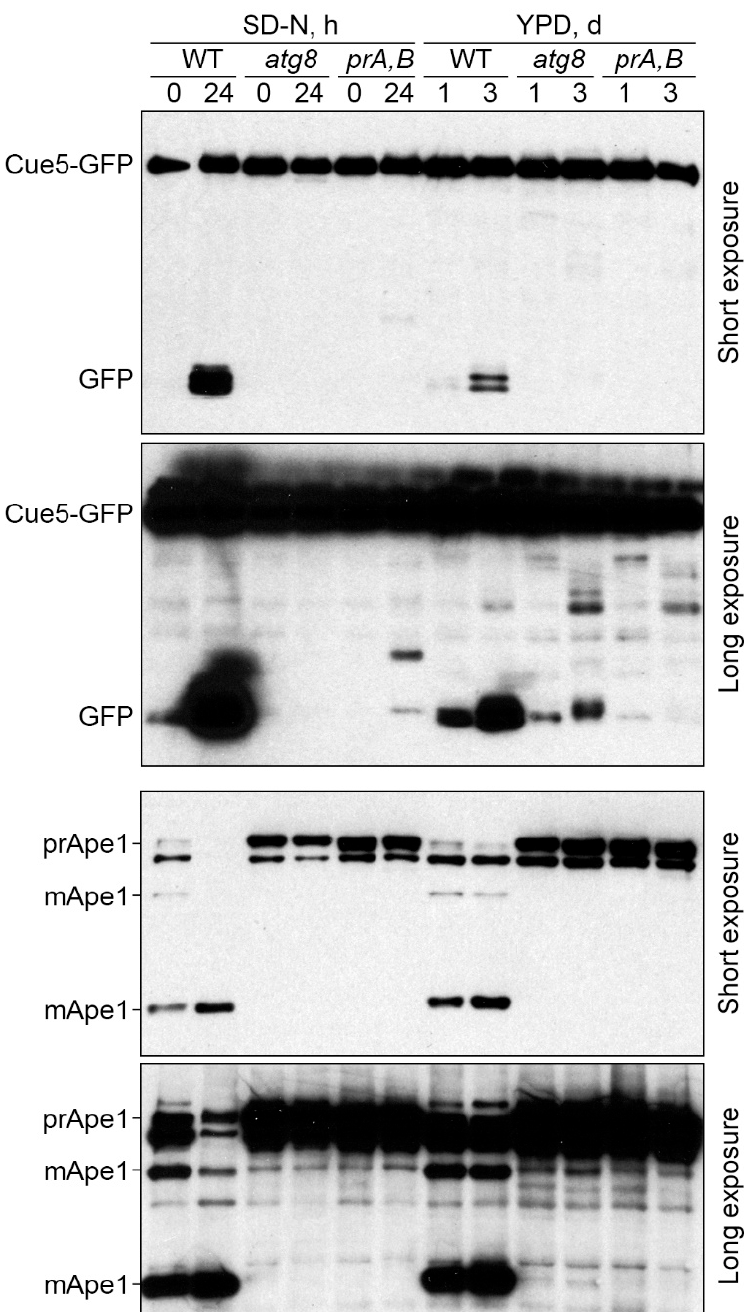
Figure 2. Cue5 is degraded by the S-phase lipophagy. The cells of WT, atg8 and prA,B strains that express Cue5-GFP were grown in YPD medium and equal biomass was taken at time-points 1 d and 3 d for testing S-phase lipophagy. Ponceau S staining (Figure S1) was used as a loading control. A fraction of cells from “YPD, 1 d” cultures was transferred to SD-N medium at OD 600 = 1 and equal volumes of cultures were taken at time-points 0 h and 24 h for testing N-starvation lipophagy (loading control not applicable). prApe1: precursor form of Ape1; mApe1: mature form of Ape1.